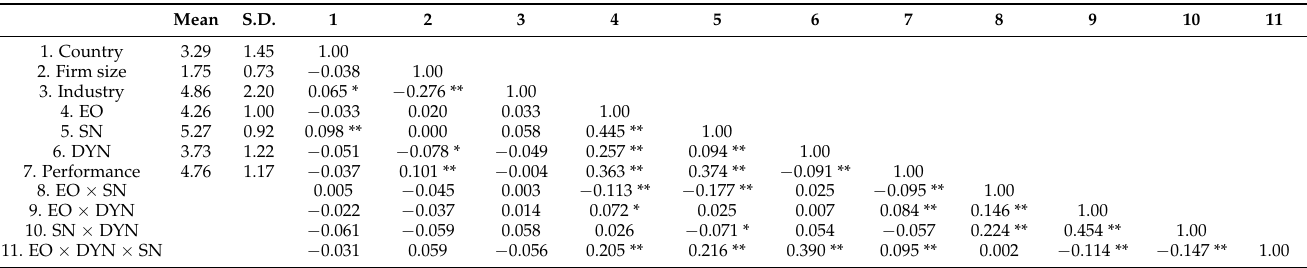
Table 2. Means, S.D.s, and correlations (n =